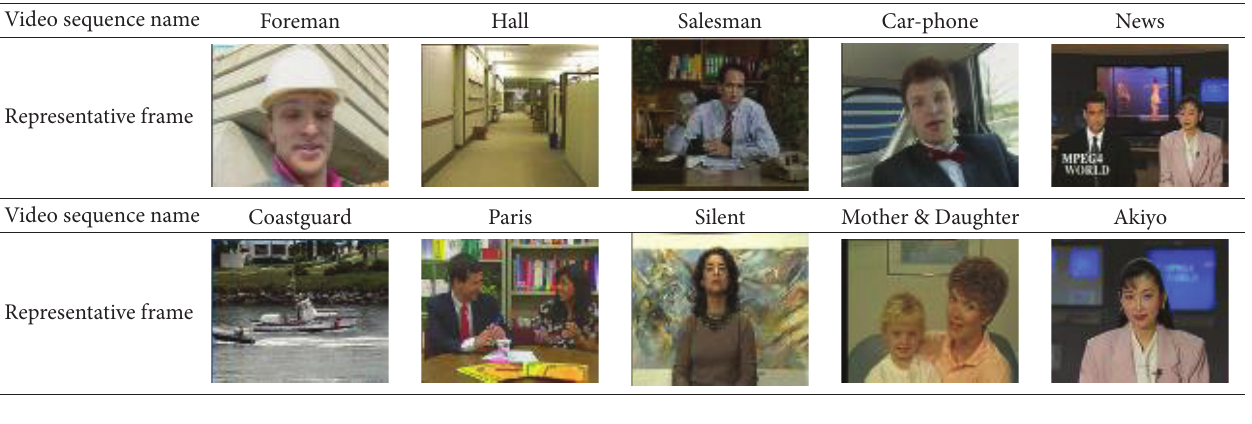
inter 16 prediction mode and the fast motion estimation algorithm with Layer 1 to Layer 3, and 3 reference frames: ROI (𝑥, 𝑦) = 1